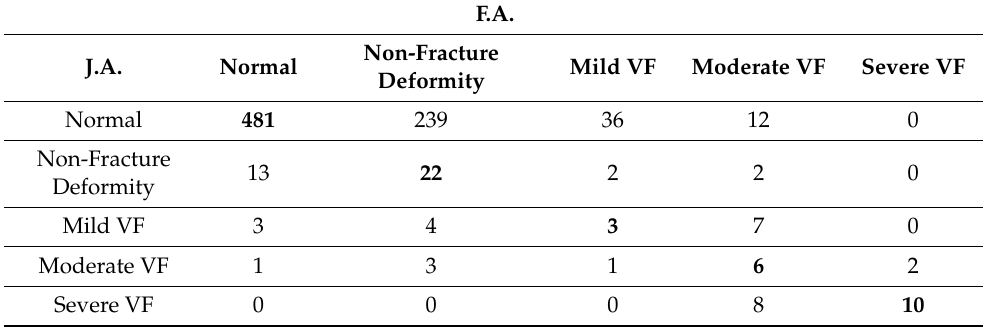
Table 3. The confusion matrix for F.A. diagnoses, compared to the gold-standard from J.A.